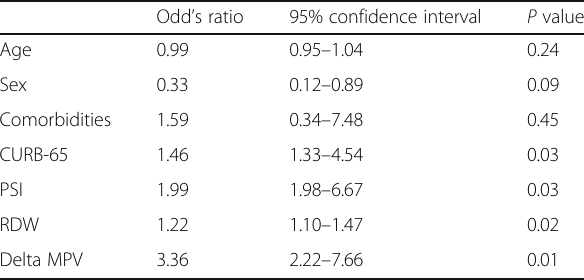
Table 3 Predictors of in-hospital mortality in patients with CAP